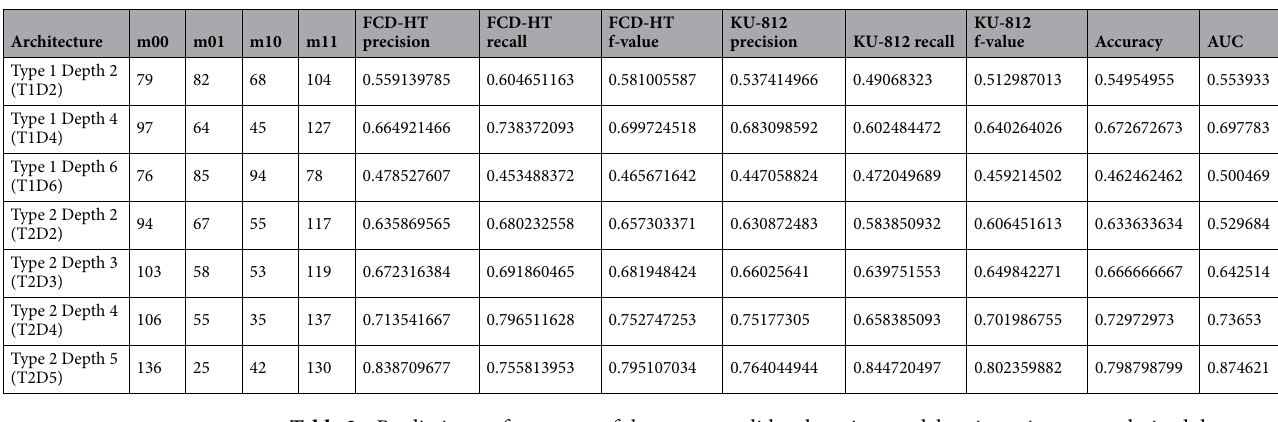
Table 2. Predictive performances of the seven candidate learning models using microscopy-derived data.